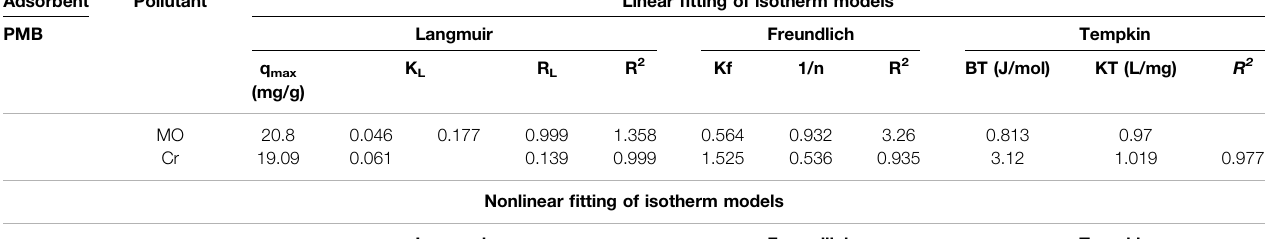
TABLE 2 | Adsorption isotherm model parameters ’ values. Adsorbent Pollutant Linear fi tting of isotherm models